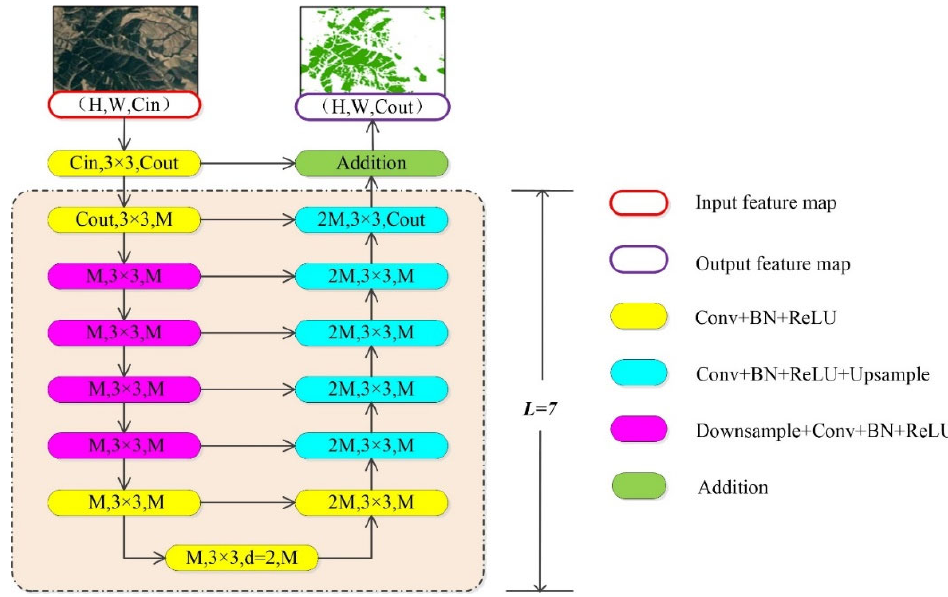
Figure 8. Structure of the residual U ‐ block (RSU).